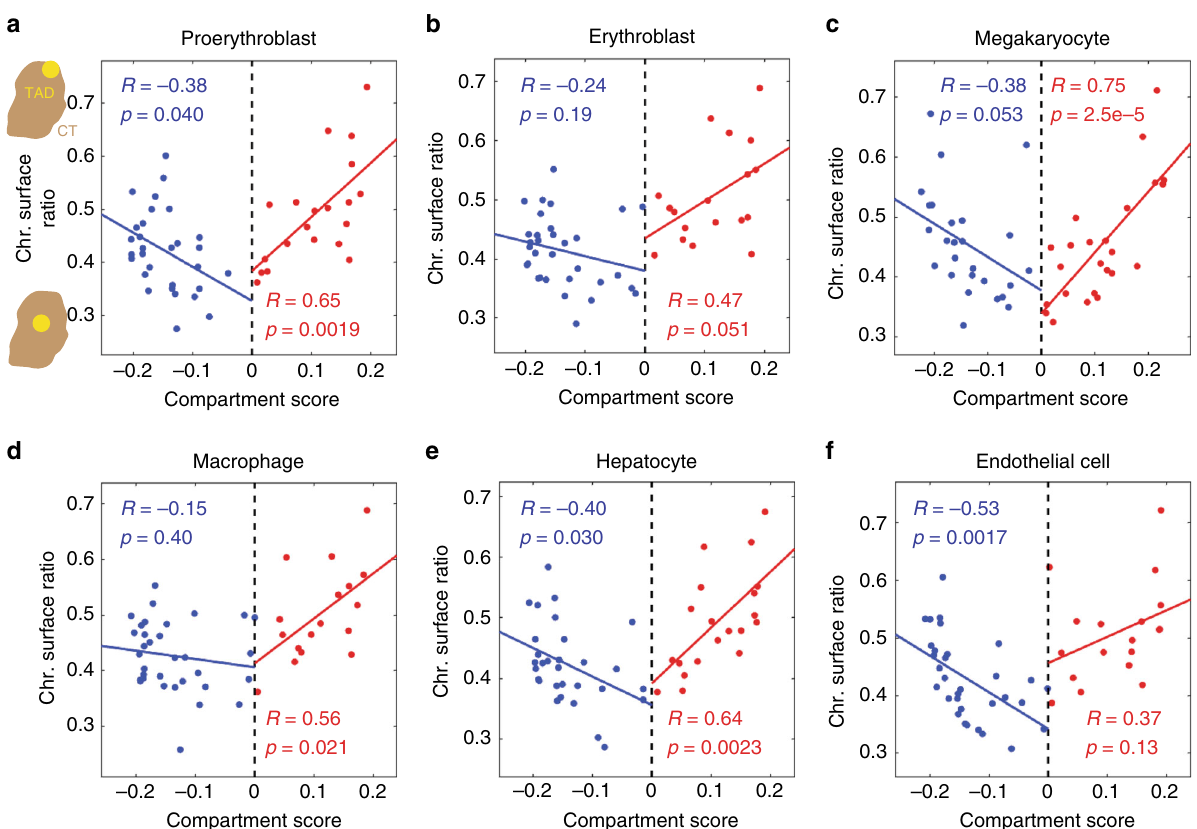
Fig. 5 Chromosome surface ratios of TADs versus their compartment scores in different cell types. a Proerythroblast. The cartoons along the y -axis of A illustrate TADs localizing to the surface or interior of the chromosome territory (CT). b Erythroblast. c Megakaryocyte. d Macrophage. e Hepatocyte. f Endothelial cell. Each dot represents a TAD. The lines show linear regression fi ts. Correlation coef fi cients (R) and the corresponding p values were calculated for compartment-B TADs (blue) and compartment-A TADs (red) separately. The p values were calculated for Pearson ’ s correlation using a two- sided Student ’ s t distribution. No adjustment was made for multiple comparisons. Source data are provided as a Source data fi